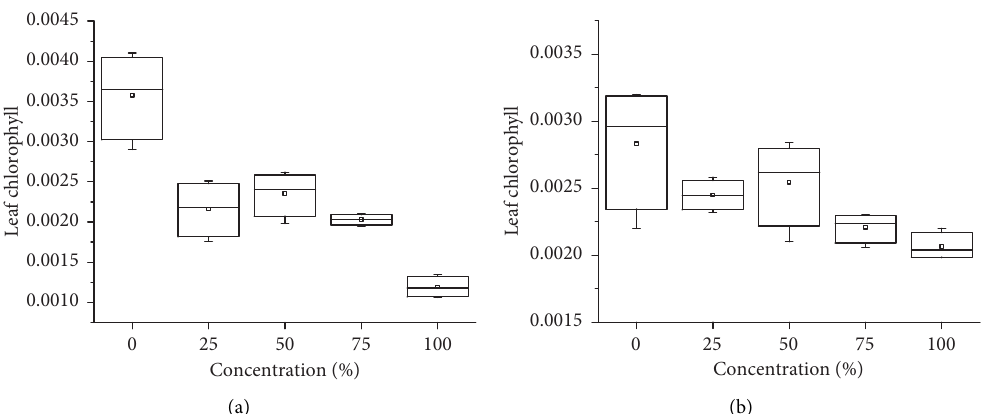
Figure 9: Leaf chlorophyll content of P. vulgaris (a) and O. sativa (b) seedlings in laboratory experiment after 7 and 14 days of treatment with S. suaveolens extracts, respectively.